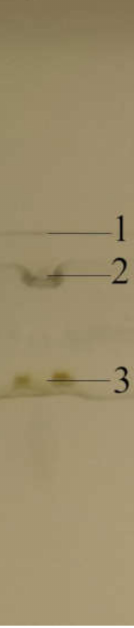
Figure 4. The chromatogram after focusing the substances of interest in the solvent front position. The dashed line marks the path of the pipette delivering the eluent, the arrows indicate the directions of the eluent migration. ( 1 ) The low retention matrix components, ( 2 ) the zone of the substance of interest (monensin) and the internal standard (nigericin), ( 3 ) high-retention matrix components. Stationary phase: HPTLC Silica gel. Plate image was captured under white light illumination. Samples: extract from premixture with monensin.